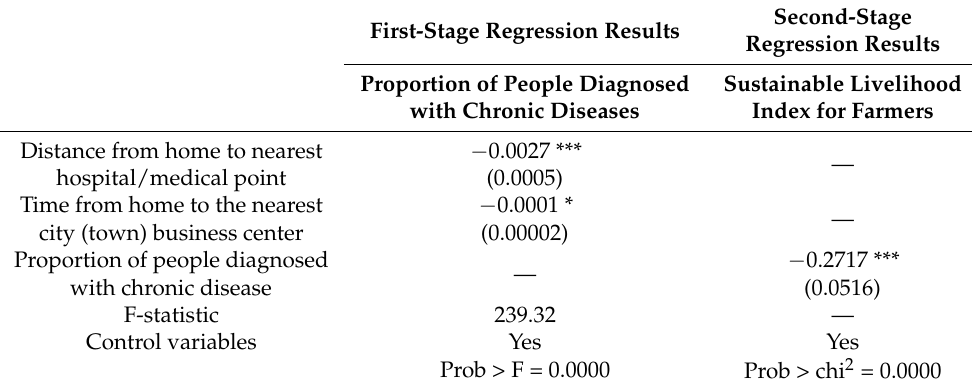
Table 5. Endogeneity test results.